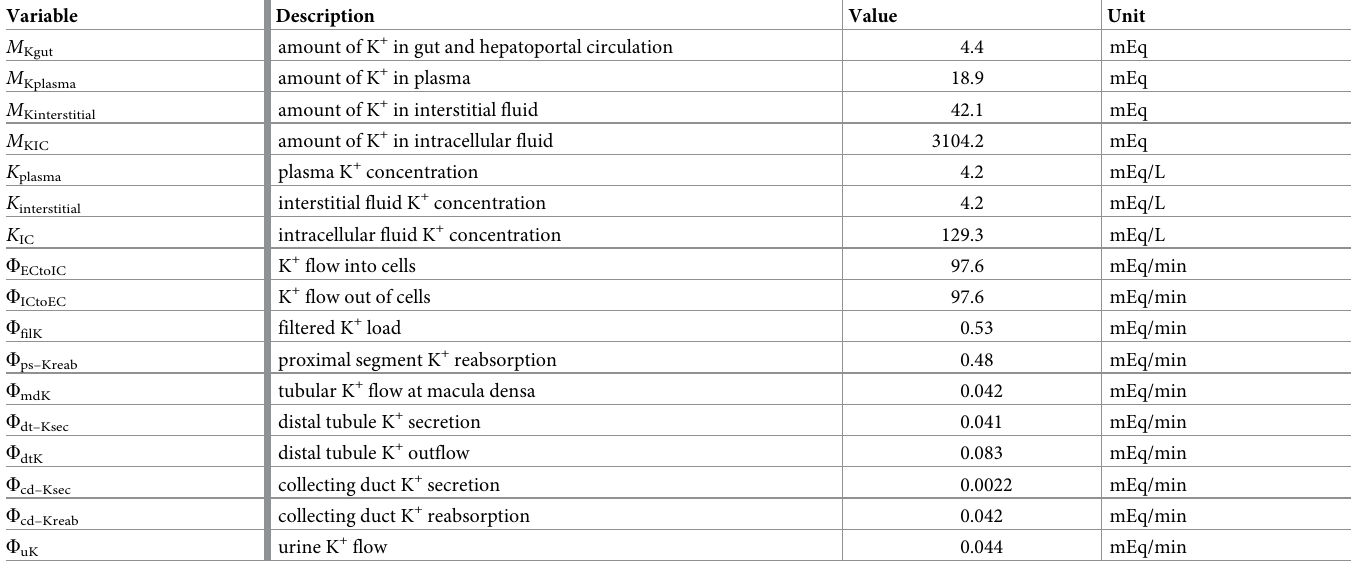
Table 2. Baseline model steady-state solution. These values are used as the initial conditions in the model simulations.